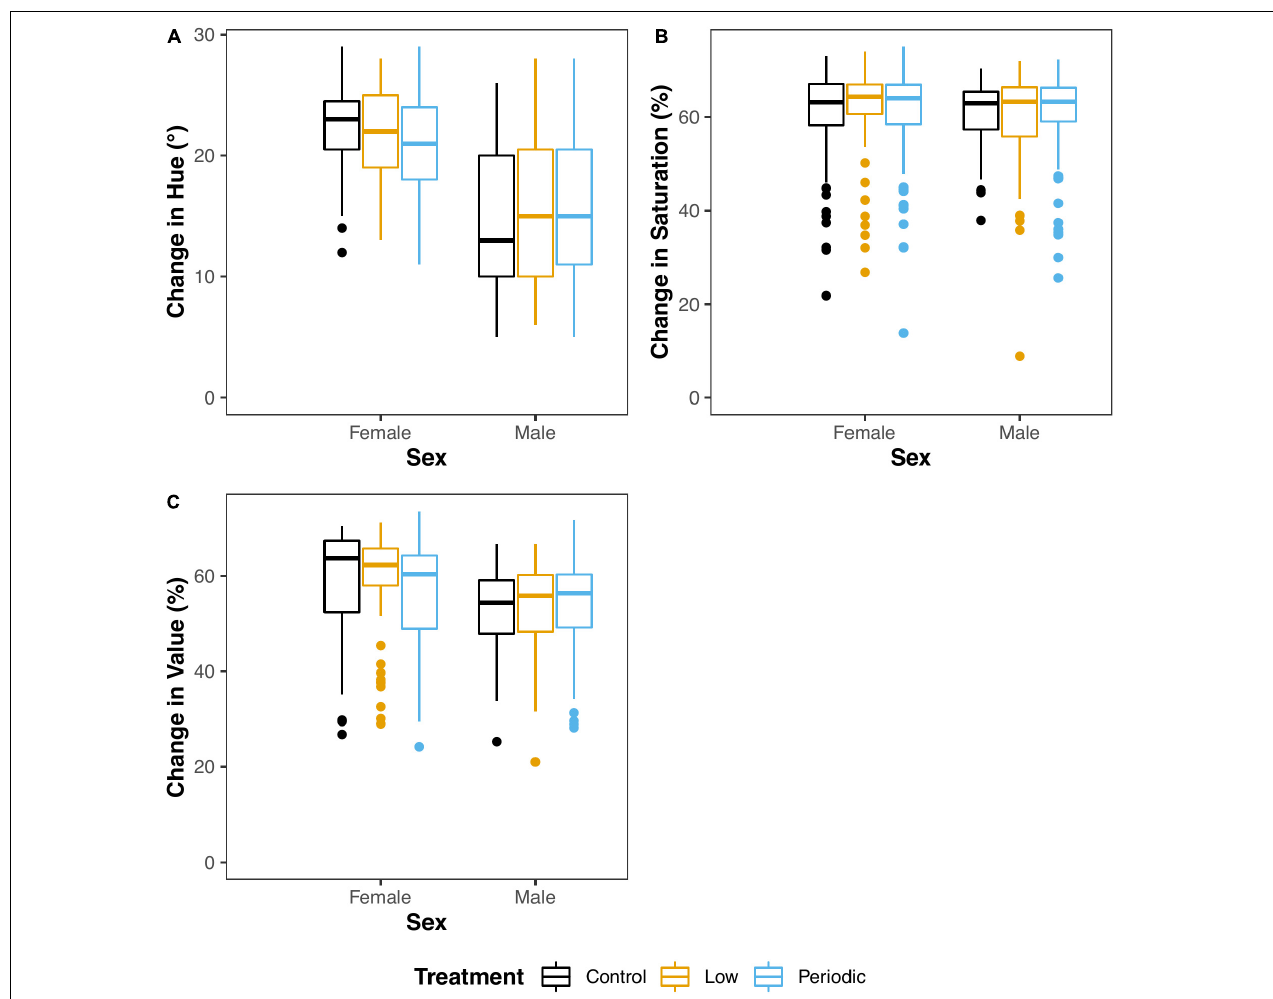
FIGURE 3 | Suboptimal embryonic incubation temperatures do not impact beak color (hue, saturation, value) development. Control, Low, and Periodic treatments are shown in black, yellow, and blue, respectively. The changes in hue (A) , saturation (B) , and value (C) are measured on the y-axis, measured in degrees and percentage, respectively. Sex is indicated on the